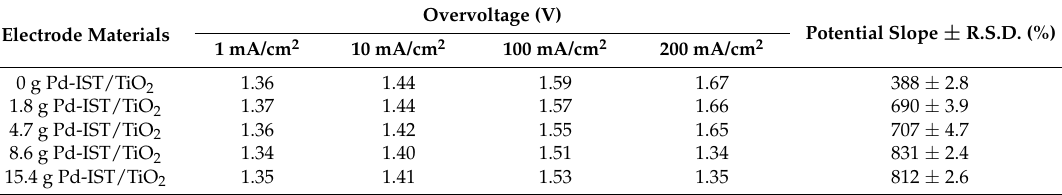
Table 3. Overvoltage and the potential slope for Pd-based electrodes.